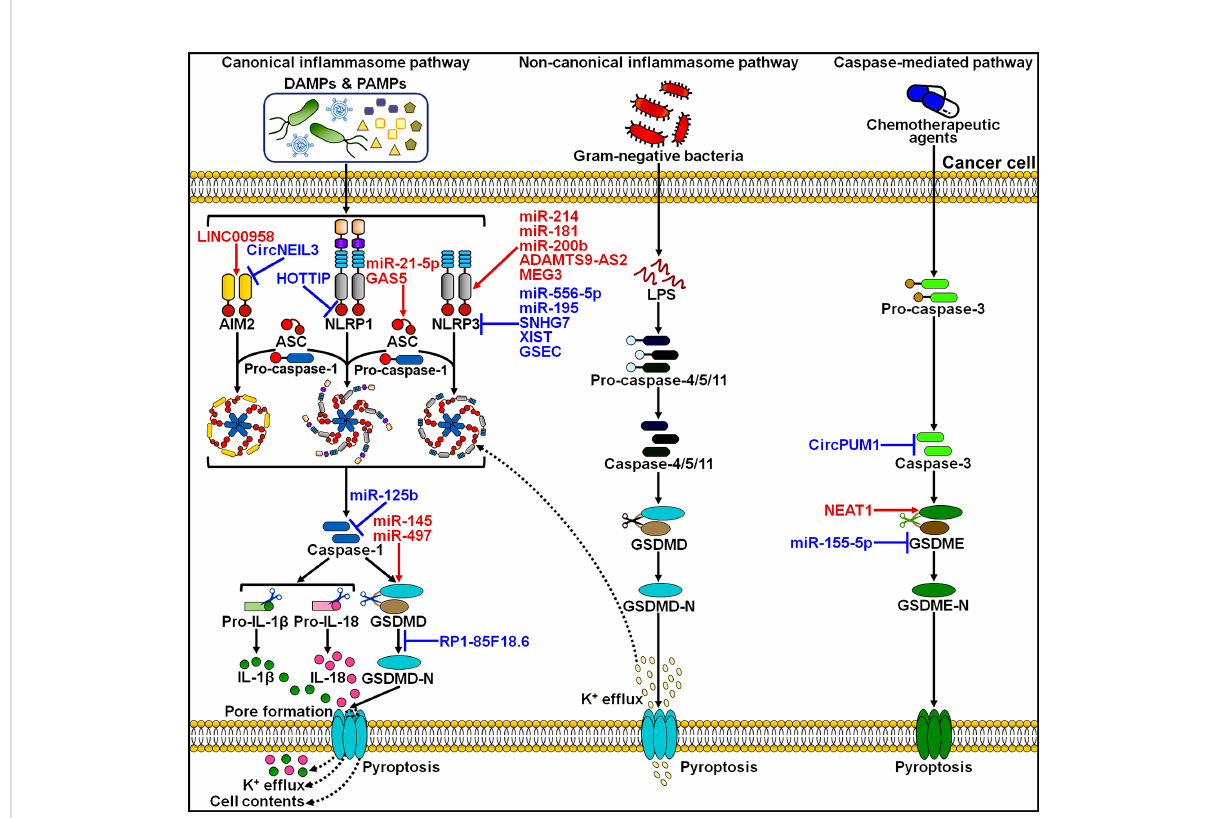
FIGURE 2 Overview of ncRNAs involved in the regulation of the pyroptosis pathways in cancer. LINC00958 was found to initiate AIM2 in fl ammasome- dependent pyroptosis. By contrast, circNEIL3 prevented DNA damage-induced AIM2 in fl ammasome activaiton, thereby restraining the pyroptosis process. HOTTIP was capable of suppressing NLRP1 in fl ammasome-mediated pyroptosis. miR-21-5p and GAS5 could activate the canonical in fl ammasome pathway by regulating ASC. miR-214, miR-181, miR-200b, ADAMTS9-AS2 and MEG3 were reported to facilitate the assembly of NLRP3 in fl ammasome, whereas miR-556-5p, miR-195, SNHG7, XIST and GSEC exerted the opposite action. miR-125b limited the activity of caspase-1, hence blocking the canonical in fl ammasome pathway. miR-145 and miR-497 drove the pyroptosis pathway by promoting GSDMD expression or activation. However, RP1-85F18.6 inhibited GSDMD cleavage and thus repressed pyroptoic cell death. CircPUM1 negatively regulated caspase-3 to interrupt the related pyroptosis pathway. NEAT1 and miR-155-5p had opposite effects on GSDME-executed pyroptosis. DAMPs, damage-associated molecular patterns; PAMPs, pathogen-associated molecular patterns; AIM2, absent in melanoma 2; ASC, apoptosis-associated speck-like protein containing a caspase activation and recruitment domain; NLRP1, nucleotide-binding oligomerization domain (NOD)-like receptor (NLR) family pyrin domain-containing 1; NLRP3, nucleotide-binding oligomerization domain (NOD)-like receptor (NLR) family pyrin domain-containing 3; GSDMD, gasdermin D; GSDMD-N, the N-terminal domain of gasdermin D; IL-1 b , interleukin-1 b ; IL-18, interleukin-18; LPS, lipopolysaccharide; GSDME, gasdermin E; GSDME-N, the N-terminal domain of gasdermin